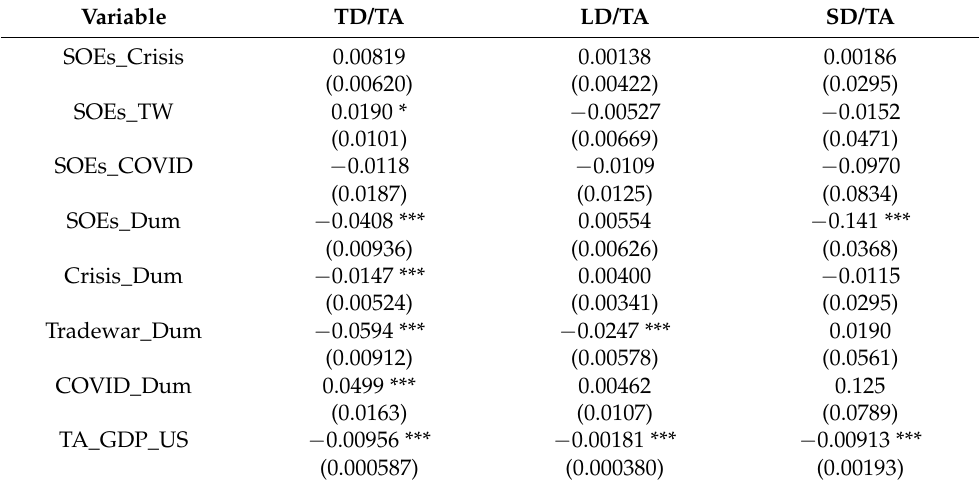
Table 5. The impacts of the Great Recession, Trade War, and COVID-19: SOEs vs.